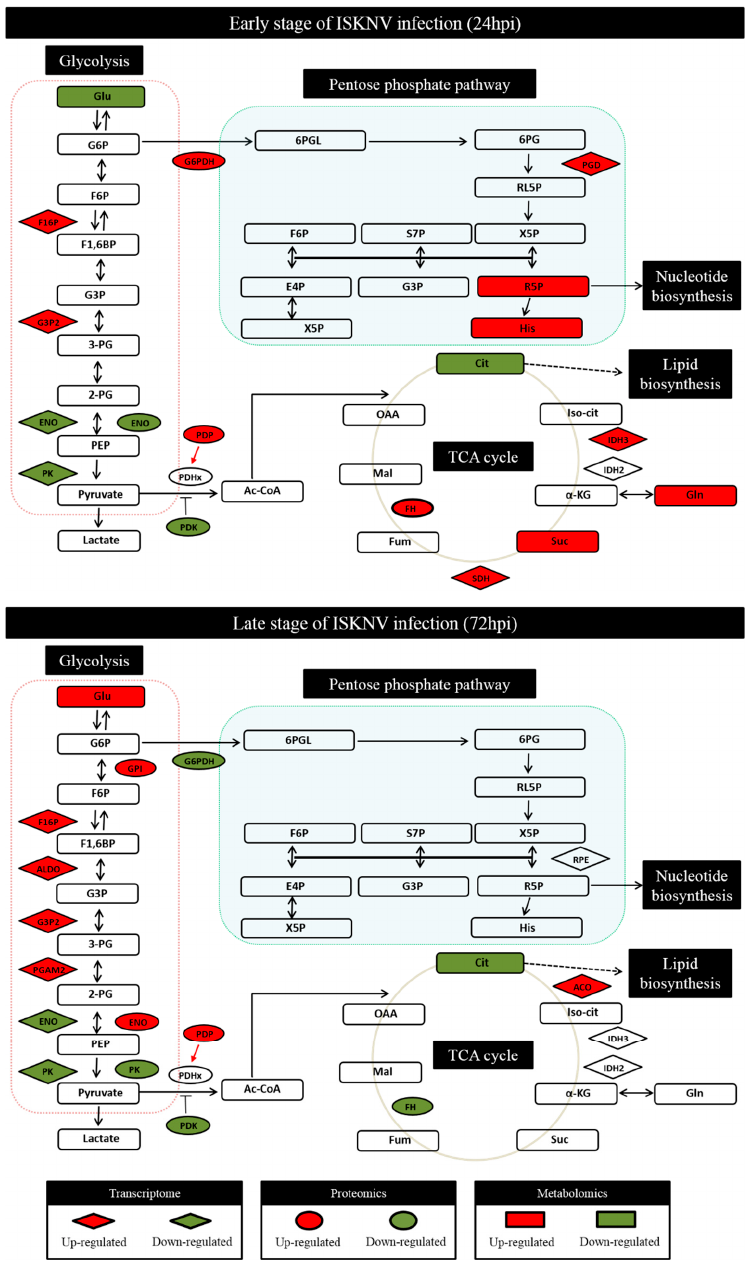
Figure 1. The infectious spleen and kidney necrosis virus (ISKNV) induced the changes of glucose metabolism in the cellular transcriptomic, proteomic, and metabolomics of Chinese perch brain cell line (CPB) cells at its replication cycle. Changes in the levels of enzymes of genes (rhombus), proteins (ellipses), and metabolites (rectangles) relative to control controls are color-coded to represent upregulation (red) or downregulation (green). Colorless boxes indicate that no difference was detected. Transcriptome date were collected from three groups of parallel samples of CPB cells using RNA-Seq. Proteomics date were collected from three groups of parallel samples of CPB cells using iTRAQ proteomics. Metabolomics data were collected from six groups of parallel samples of CPB cells using LC-MS. Numeric values for the transcriptomic and proteomic data are given in Hu et al.